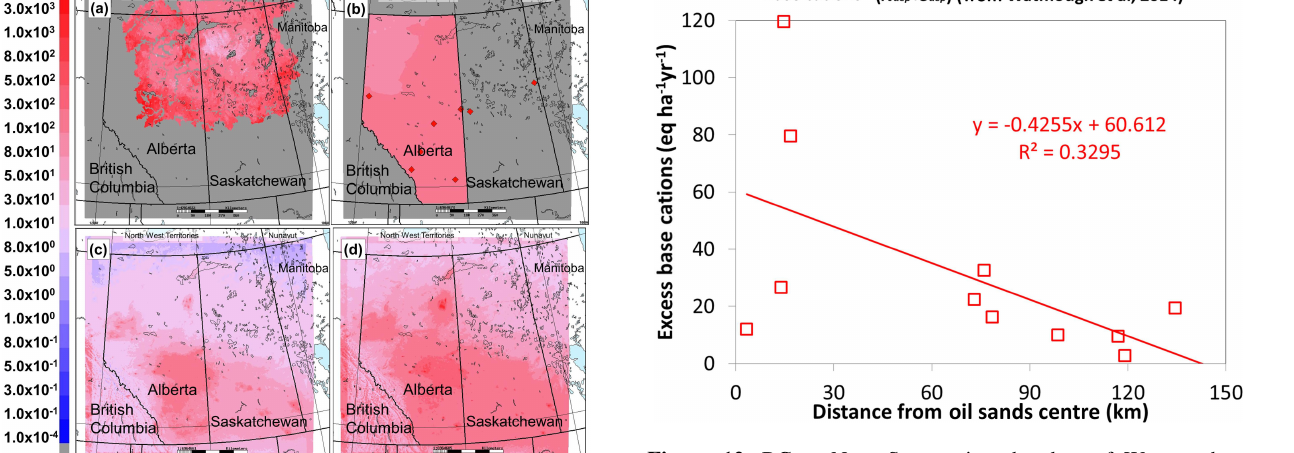
Figure 12. BC dep –N dep –S dep , using the data of Watmough et al.